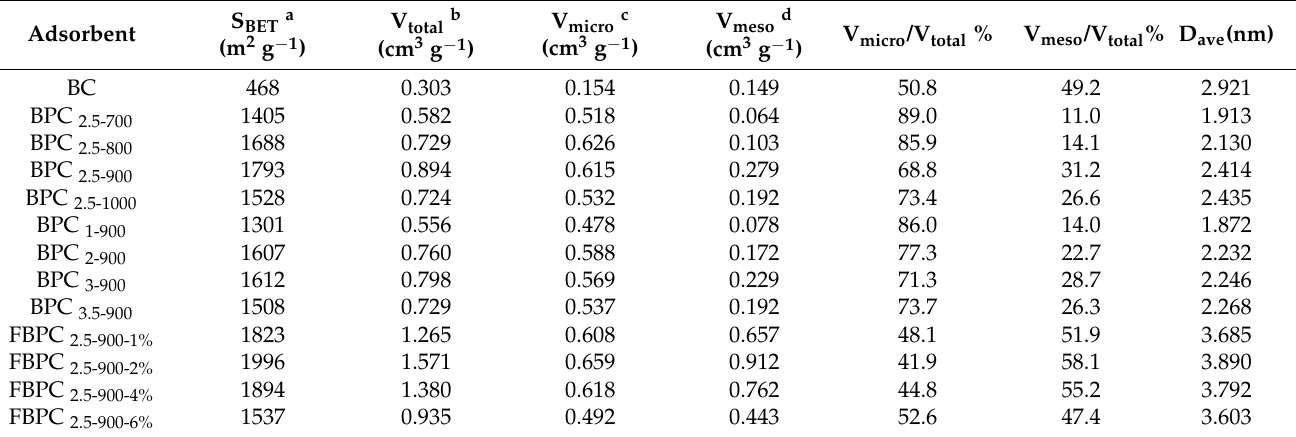
Table 1. Summary of the pore characterization data of the BC, BPC, and FBPC samples.